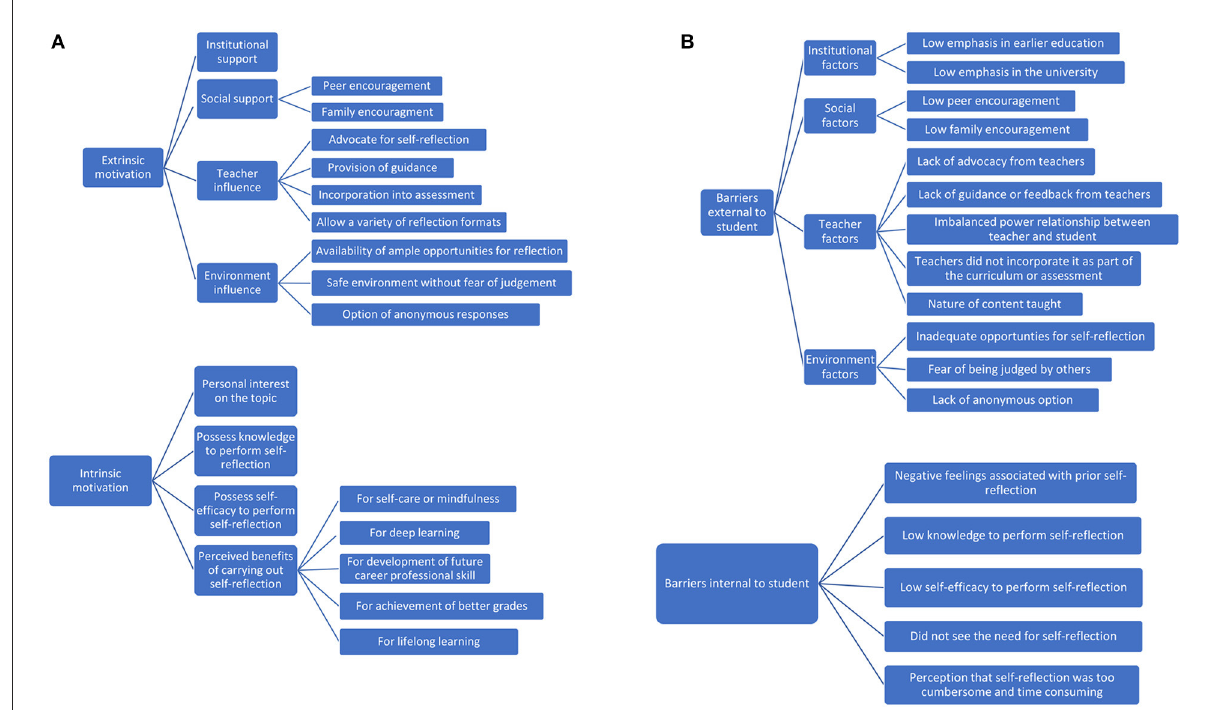
FIGURE1 (A) Themes and subthemes of the motivating factors to carrying out regular self-reflection among students. (B) Themes and subthemes of the barriers to carrying out regular self-reflection among students.